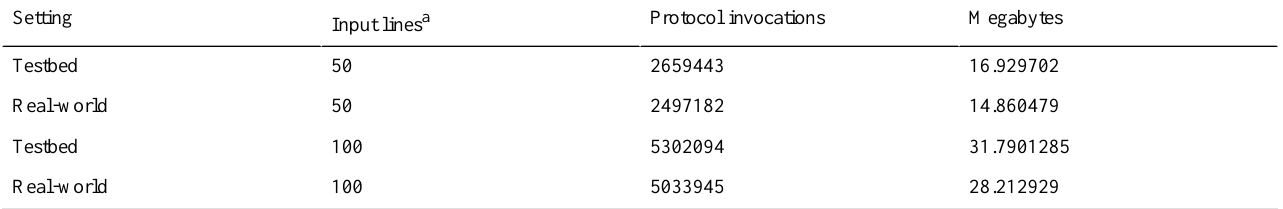
Table 4. Comparison of the testbed and real-world measurement results for the log-rank algorithm (median values). MegabytesProtocol invocationsInput lines a Setting